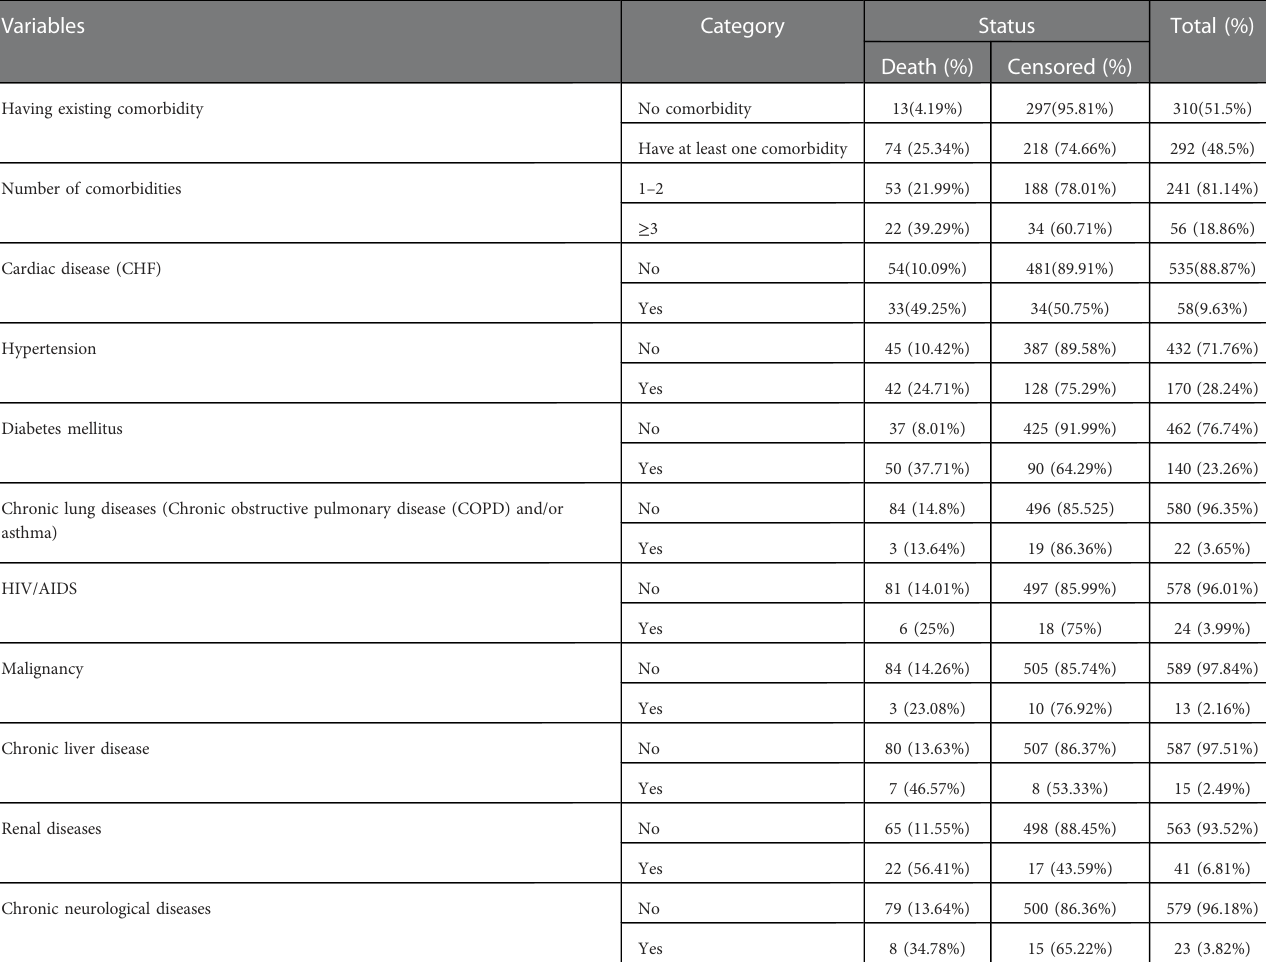
TABLE 2 Pre-existing comorbidity status of adult COVID-19 patients at Eka Kotebe General Hospital, COVID-19 Treatment Center, Addis Ababa, Ethiopia, 2021.